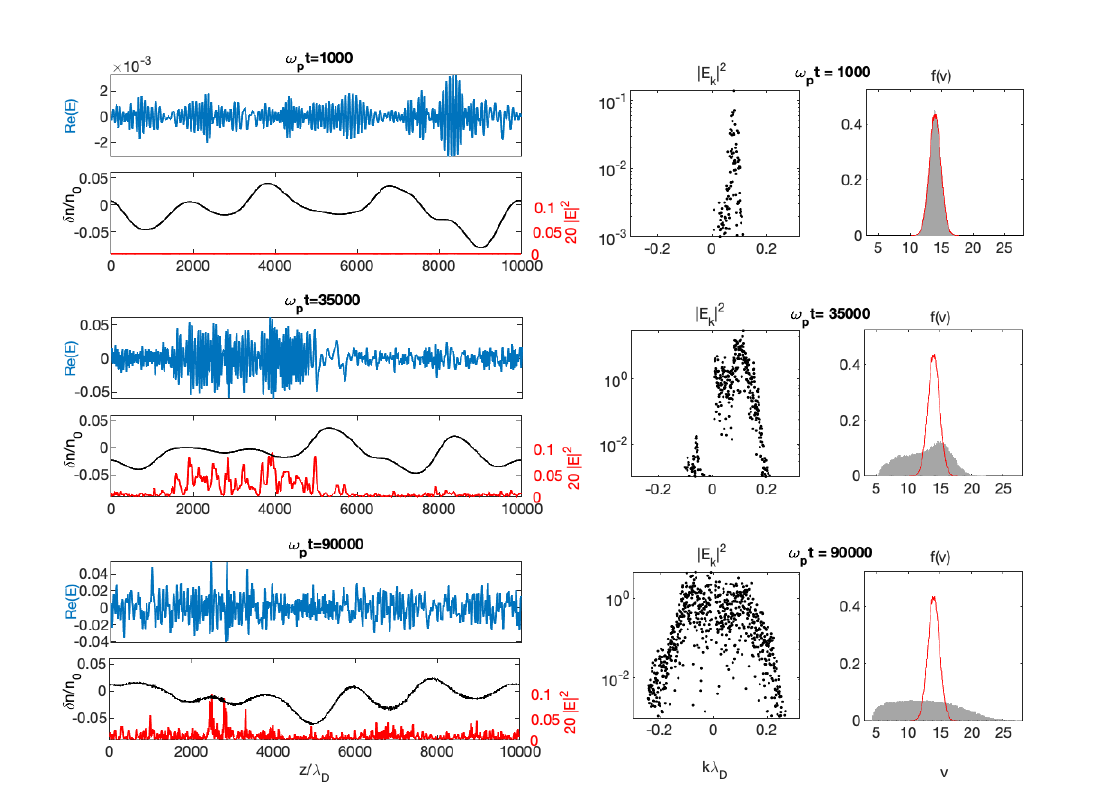
Figure 4. Beam dynamics’ and wave packet’s evolution at three moments of times, ω p t = 1000, 35,000 and 90,000 (from upper to lower rows). ( Left panels): Spatial profiles of the electric field envelope Re E (blue) and of the energy density | E | 2 × 20 (red), superposed to the density fluctuations δ n / n 0 (black). ( Middle panels): Corresponding electric field spectra | E k | 2 in logarithmic scales. ( Right panels): Corresponding electron velocity distributions f ( v ) (grey surfaces), superposed to the initial distribution (red curves). Main parameters are the following : v b = 14/ v T , ∆ v b / v b = 0.08, n b / n 0 (cid:39) 2.5 × 10 − 5 , ∆ n (cid:39) 0.03. All variables are normalized. (Reproduced by permission of the AAS